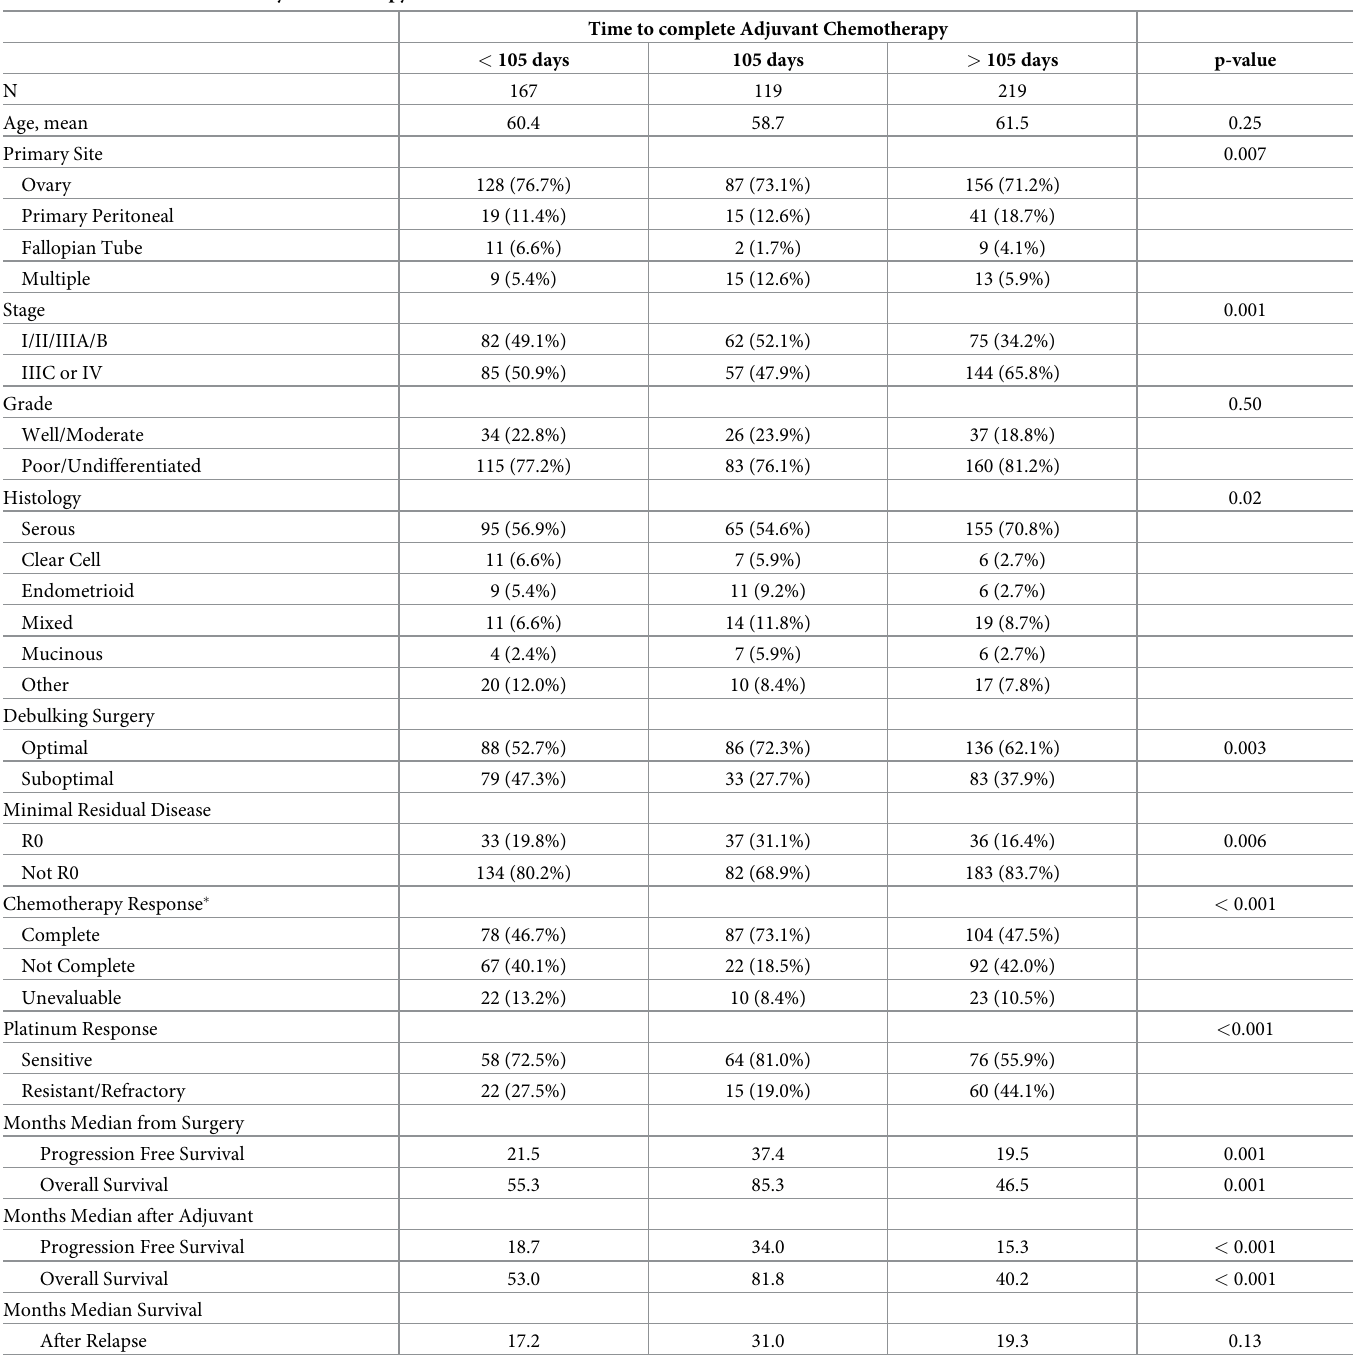
Table 1. Patient characteristics by chemotherapy